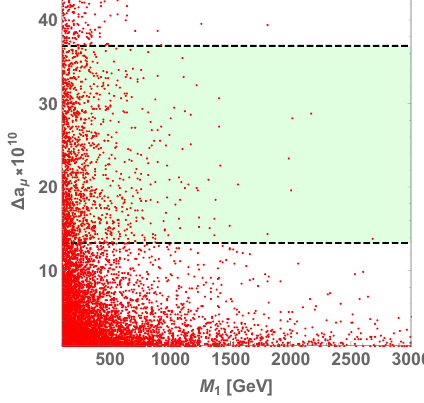
( Z 0 ) , ∆ C 10 ( Z ) } plain where each point satisfies phe- 9 ( Z 0 ) , | ∆ C 9 ( Z ) |} plain. 9